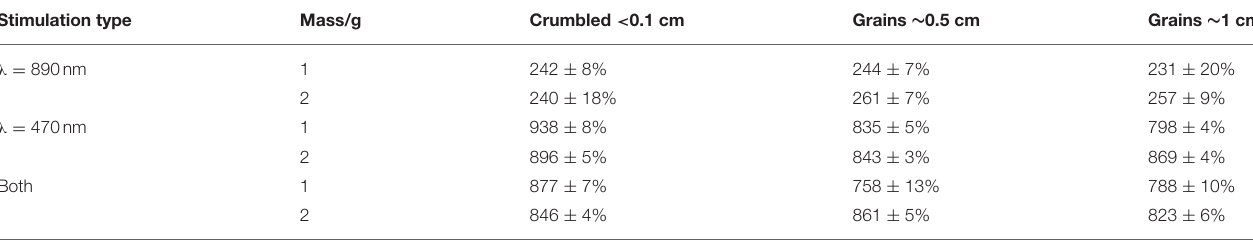
TABLE 1 | Number of counts measured for the unirradiated samples for two different masses and three different grain sizes (data acquired with Reader 1). Stimulation type